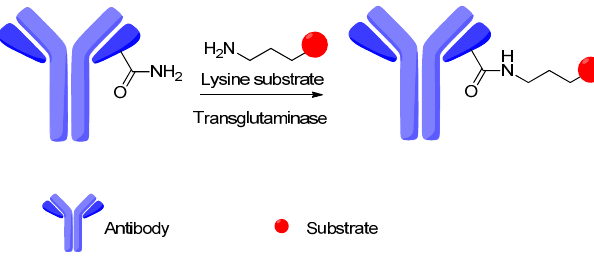
Figure 18. A glutamine side chain is ligated to a lysine side chain by transglutaminase.